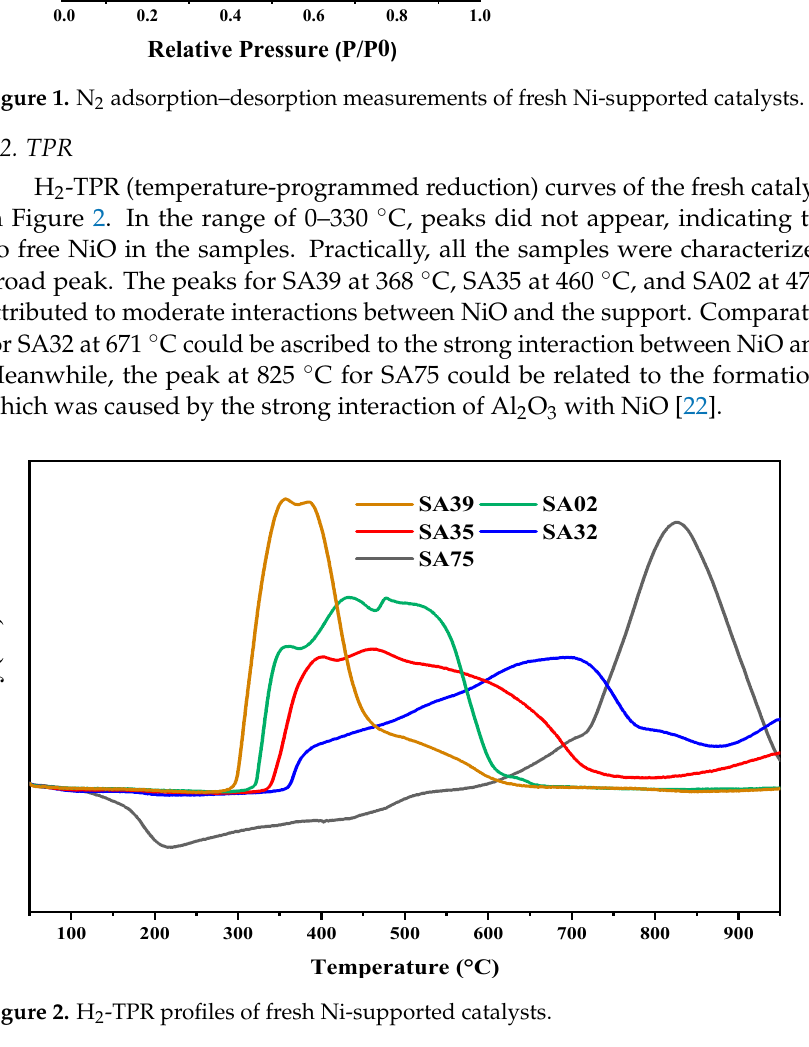
To identify the phases, Figure 3 shows the XRD profiles of fresh catalysts. XRD peaks of Al 2 O 3 and NiAl 2 O 4 appear in Figure 3 at 2 θ = 37.3, 46.0, and 66.5 ◦ (JCPDS 86-1410). The peaks for NiO overlay those of Al 2 O 3 and appear at 2 θ = 37.3, 46.0, and 66.5 ◦ (JCPDS 47-1049), with the reflections of 111, 200, and 220, respectively, indicating that these Ni- comprising phases were highly scattered on the surface of the supports [23]. Commonly, a broad peak at around 22 ◦ was found for the Ni/SiO 2 catalysts, which were assigned to